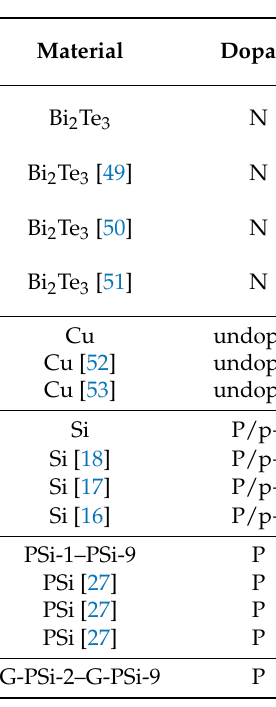
Table 3. Summary of materials